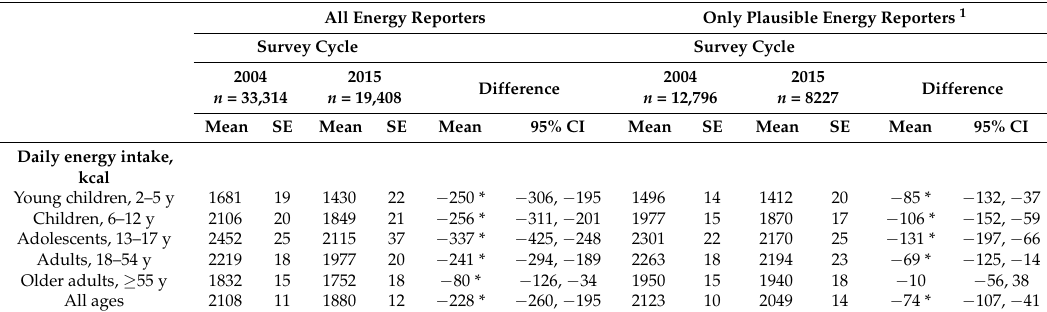
Table 4. Differences in average daily energy intake (kcal/day) between 2004 and 2015 among Canadians ≥ 2 y (all energy reporters and only plausible energy